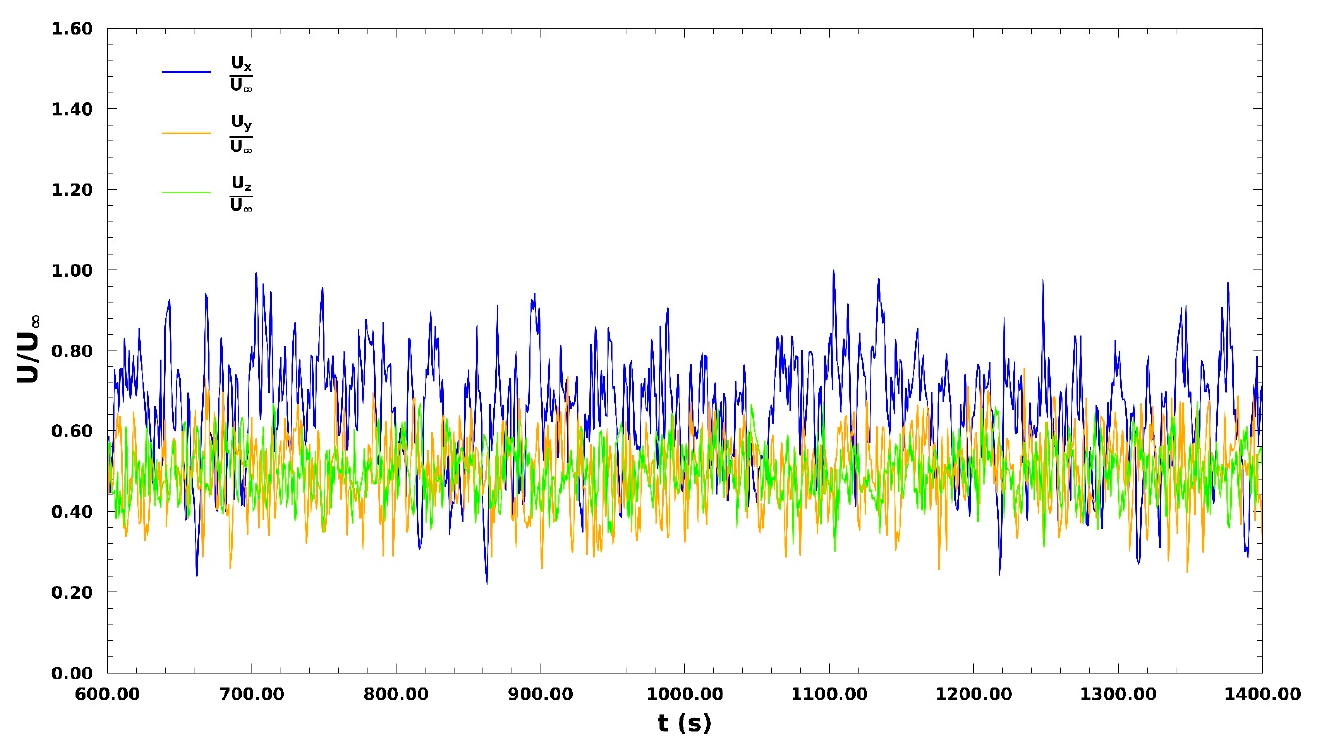
Figure 7. Velocity fluctuations of u x /u ∞ , u y /u ∞ , u z /u ∞ at point X: 10 H, Y: 5.5 H, Z: 0.5 H from 600 up to 1400 (s) for Scenario A.